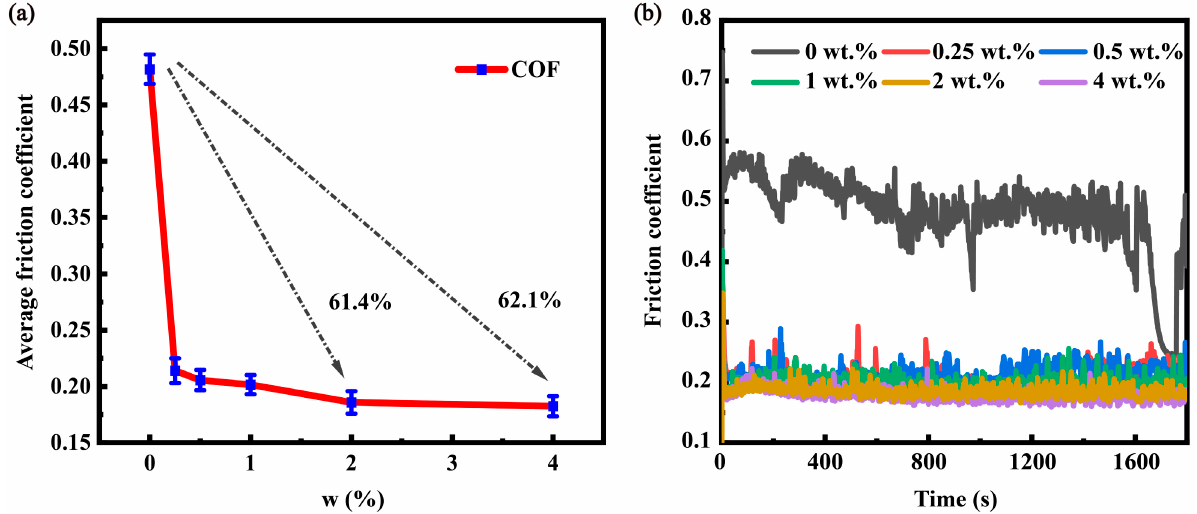
Figure 5. The ( a ) COF and ( b ) friction coefficient curves of frequency ramp-up reciprocation with the JD2000 concentrations ranging 0–4 wt.% on the steel plates.